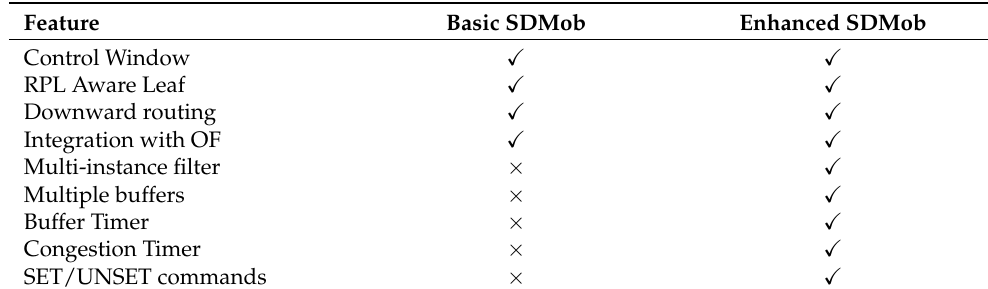
Table 2. Comparing main features of basic SDMob and enhanced